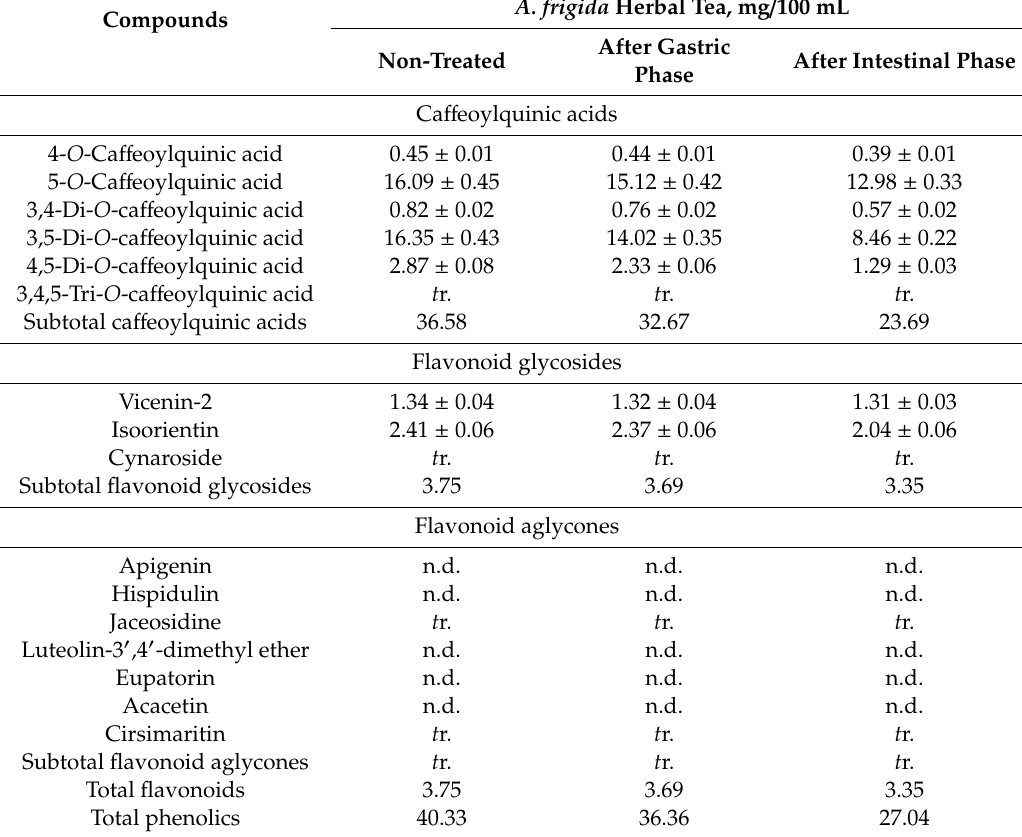
Table 3. Content of selected ca ff eoylquinic acids and flavonoids in A. frigida herbal tea before and after in vitro treatment by the simulated gastric and intestinal media (mg / 100